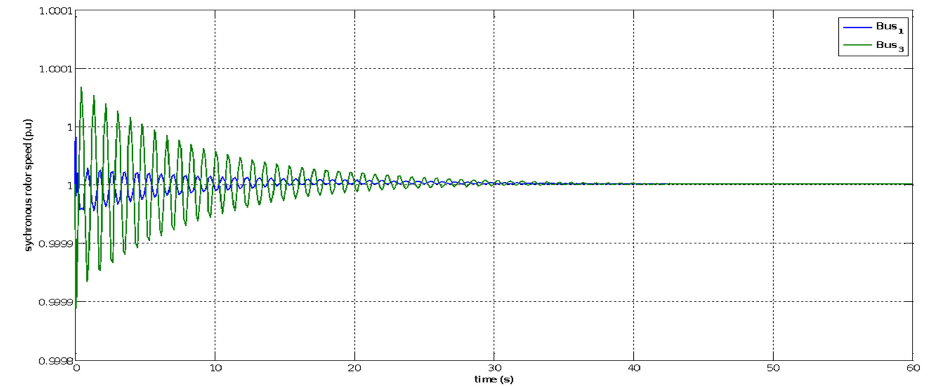
Figure 28. Response of the rotor angle at synchronous generators power plant at bus 1 and bus 3 during the base case.